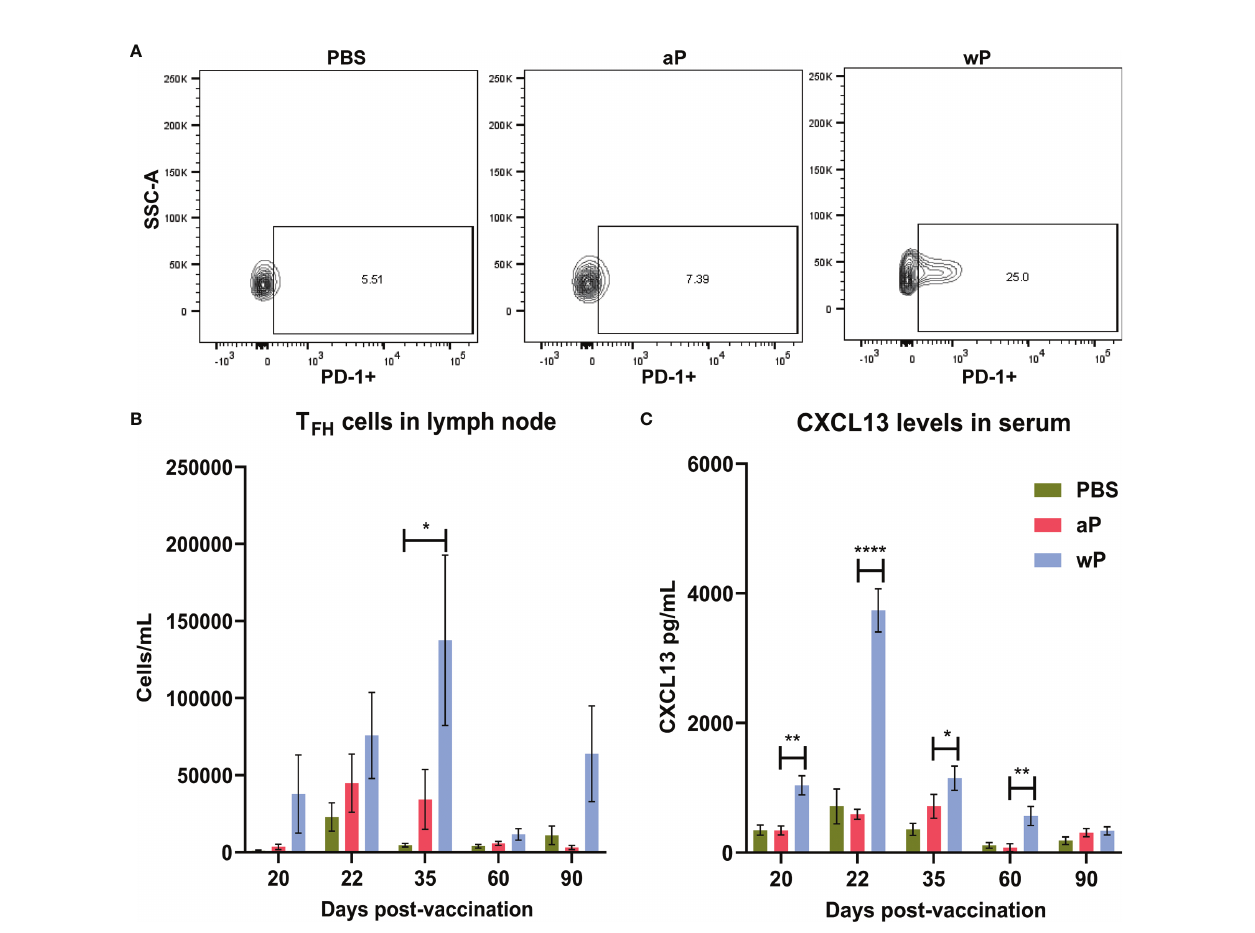
FIGURE 3 | T follicular helper cell and CXCL13 responses in the draining lymph node are signi fi cantly increased in wP immunized CD1 mice compared to mock immunized animals. Flow cytometry was performed using single cell suspensions from the draining lymph node to identify T FH cells. (A) Representative contour plots of PBS, aP, and wP groups showing T FH cells gated on CD4 + CD3 ϵ + CXCR5 + PD-1 + . (B) Group comparisons of T FH cells in the draining lymph node of non-challenged, immunized mice. (C) CXCL13 levels (pg/mL) were measured in the blood serum of non-challenged, immunized mice. Day 20 is from one independent experiment (n=4). Day 22, 60, and 90 are from two independent experiments (n=8). Day 35 is from four independent experiments (n=16). The p -values were calculated for each time point using ANOVA followed by a Tukey ’ s multiple-comparison test, * p < 0.05, ** p < 0.01, and **** p < 0.0001. Error bars are mean ± SEM